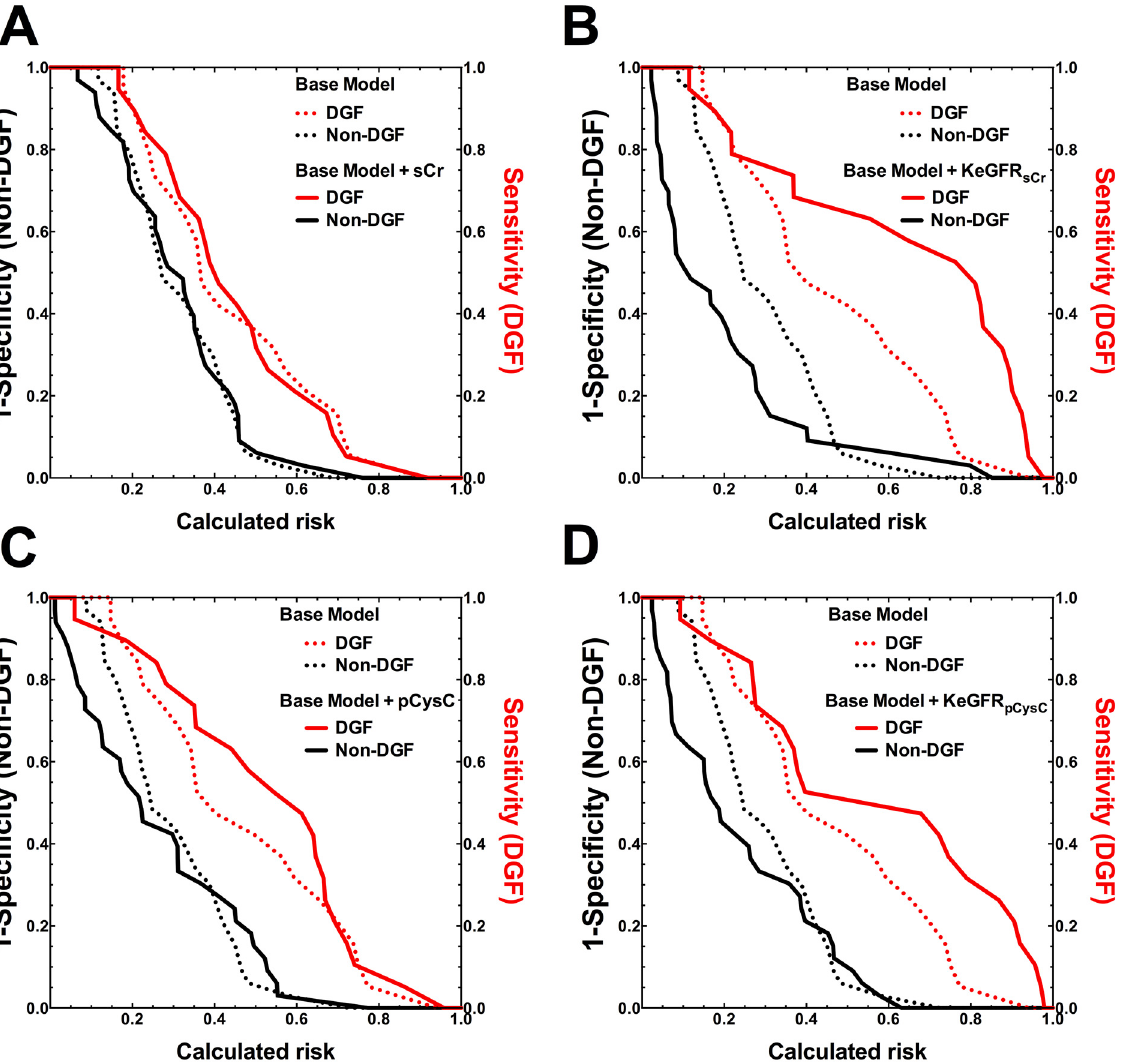
Fig 4. Clinical model enhancement by measured and calculated variables at 12h. A: serum creatinine (sCr), B: estimated GFR using sCr (KeGFR sCr ) C: plasma Cystatin C (pCysC), D: estimated GFR using pCysC (KeGFR pCysC ).